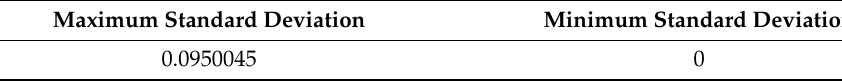
Figure 16. Acceleration monitoring of four sensor devices. Table 1. Standard deviation of accelerations at each timestamp.